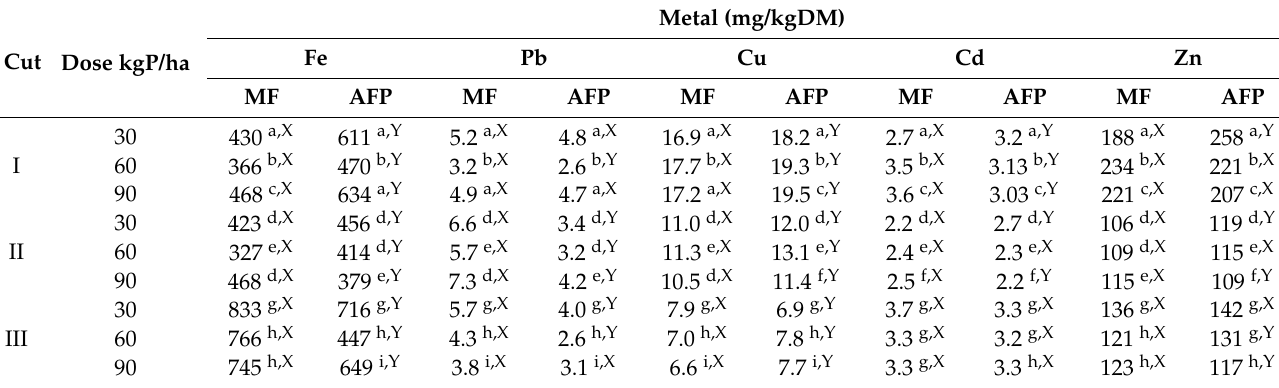
Table 3. Metal content in Italian ryegrass depending on the cut and type and amount of fertilization.